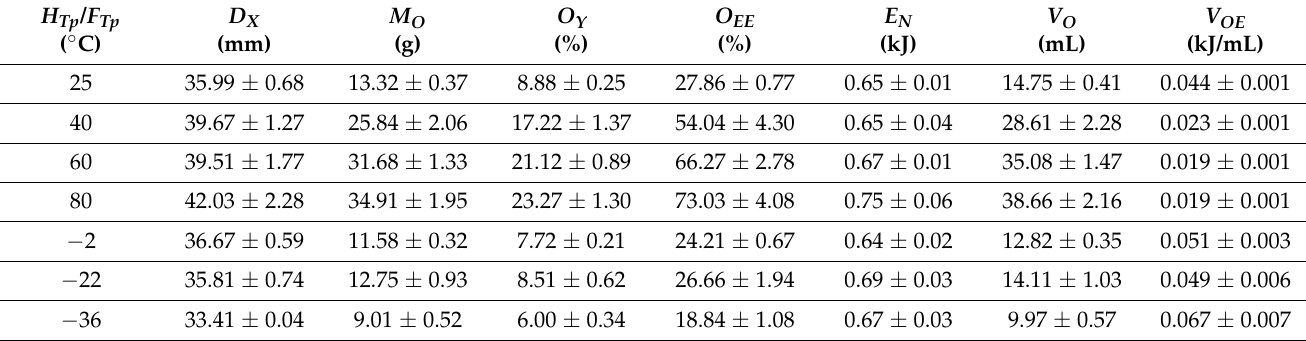
Table 1. Calculated parameters from the heating and freezing pretreatments of bulk rapeseeds.